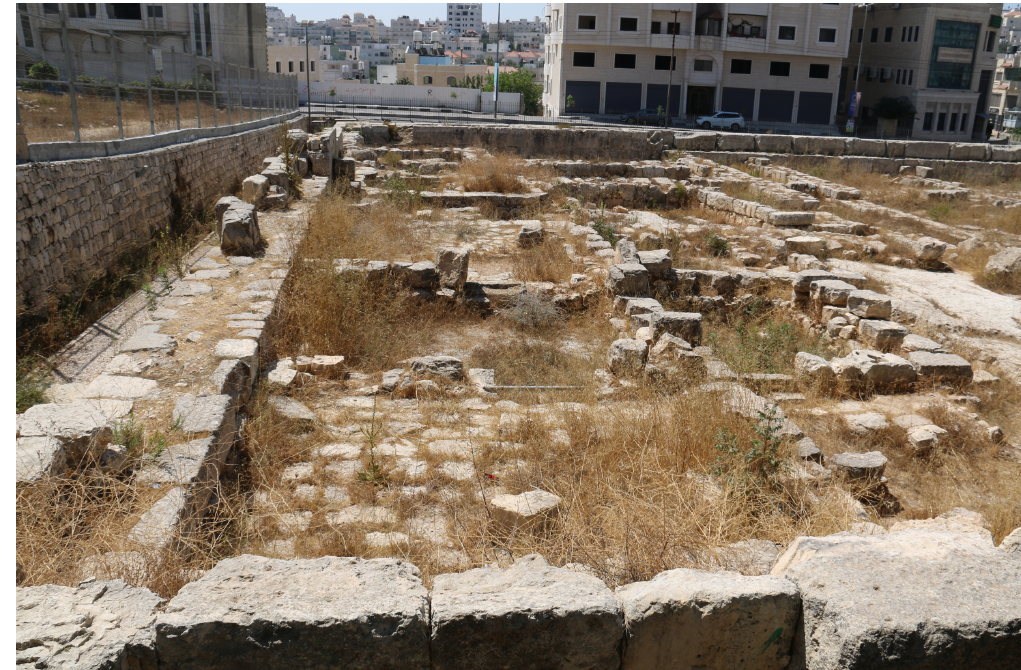
Figure 3 View from northeastern corner over the Constantinian structures. In the foreground, the “living rooms” of Abraham and Sarah. The large cubes of the enclosure wall at the lower edge of the picture are typically Herodian (photo: Katharina Heyden 09/2019).